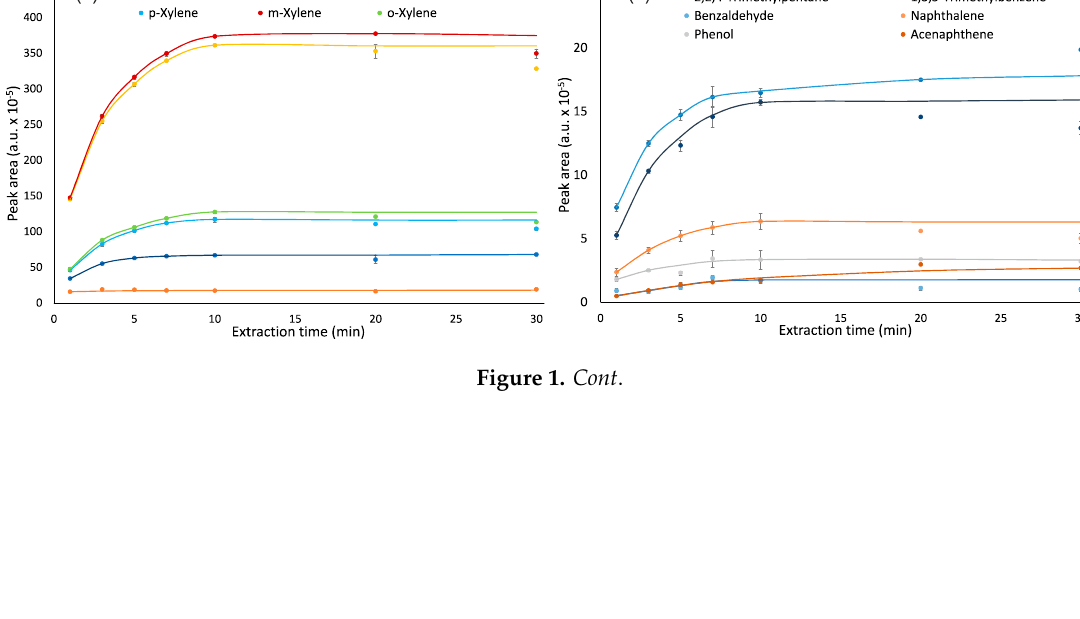
Figure 1. Effect of extraction time on responses of analytes: ( a )—benzene, toluene, ethylbenzene, m,p,o -xylenes; ( b )—2,2,4-trimethylpentane, benzaldehyde, 1,3,5-trimethylbenzene, naphthalene, acenaphthene; ( c )— n -heptane, n -decane, n -undecane, fluorene, methyl ethyl ketone, 1,2- dichloroethane, 3-picoline, and ( d )—propylbenzene, n -hexadecane, 1,2,4-trimethylbenzene, chlorobenzene, 1,1,2,2-tetrachloroethylene, methylene chloride. The increase in desorption time above 1 min had no significant effects on responses of all studied VOCs (Figure S2 in Supplementary Materials). After this time, the responses varied by 0.43–15%. Therefore, the desorption time of 1 min was chosen as the optimal. 3.3. Effect of Storage Time During transportation and storage of air samples, concentrations of analytes can decrease due to their decomposition, losses via leaks and adsorption to internal walls of a vial and septum. The approach proposed by Baimatova et al. [25] was used to minimize the losses of analytes. The goal of this experiment was to estimate losses of analytes during their storage on the autosampler tray. Figure 2 shows the effect of storage time on responses of analytes. Two-sample two-tailed t-tests indicated that the changes in responses of n -undecane, acenaphthene and fluorene in relation to initial values were significant ( p < 0.05 at RSD = 10%) after 24 h of storage (Table S4 in Supplementary Materials), while responses of other 22 analytes were stable. After 48 h of storage, changes in responses of n -undecane, n -hexadecane, acenaphthene and fluorene were significant. Greater losses of more hydrophobic analytes could be explained by their adsorption to a hydrophobic surface of a PTFE-lined septum being in direct contact with air. Despite these septa being considered highly inert, adsorption of very hydrophobic compounds by PTFE was earlier reported in the literature [36]. For achieving the greatest accuracy for these analytes, samples should be analyzed as quickly as possible, e.g., during the first 8 h after